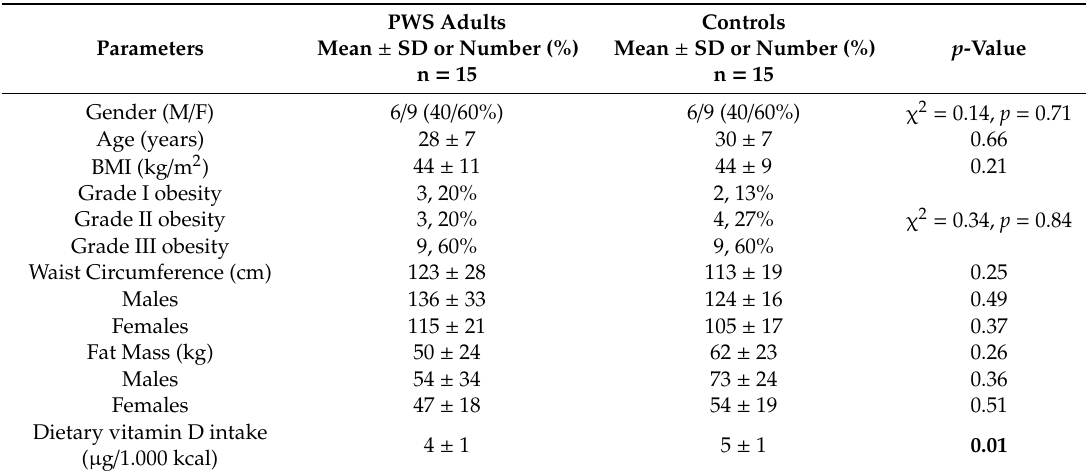
Table 1. Gender, age, anthropometric characteristics, fat mass, and dietary vitamin D intake of the study